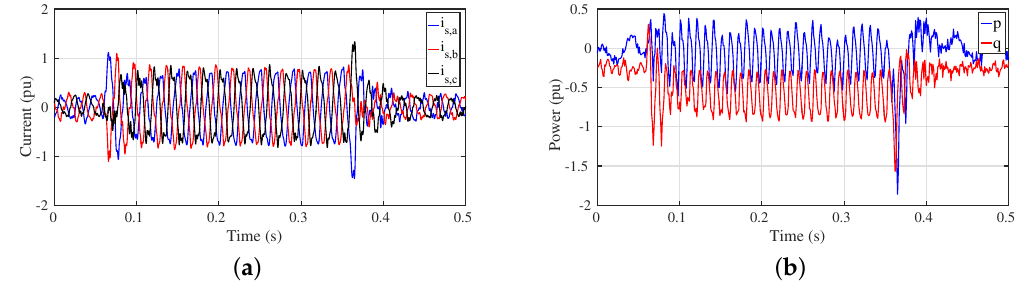
Figure 13. ( a ) Current waveforms and ( b ) instantaneous p and q waveforms for Scenario 1.